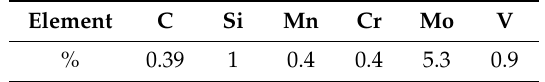
Table 1. Chemical composition of the investigated AISI H13